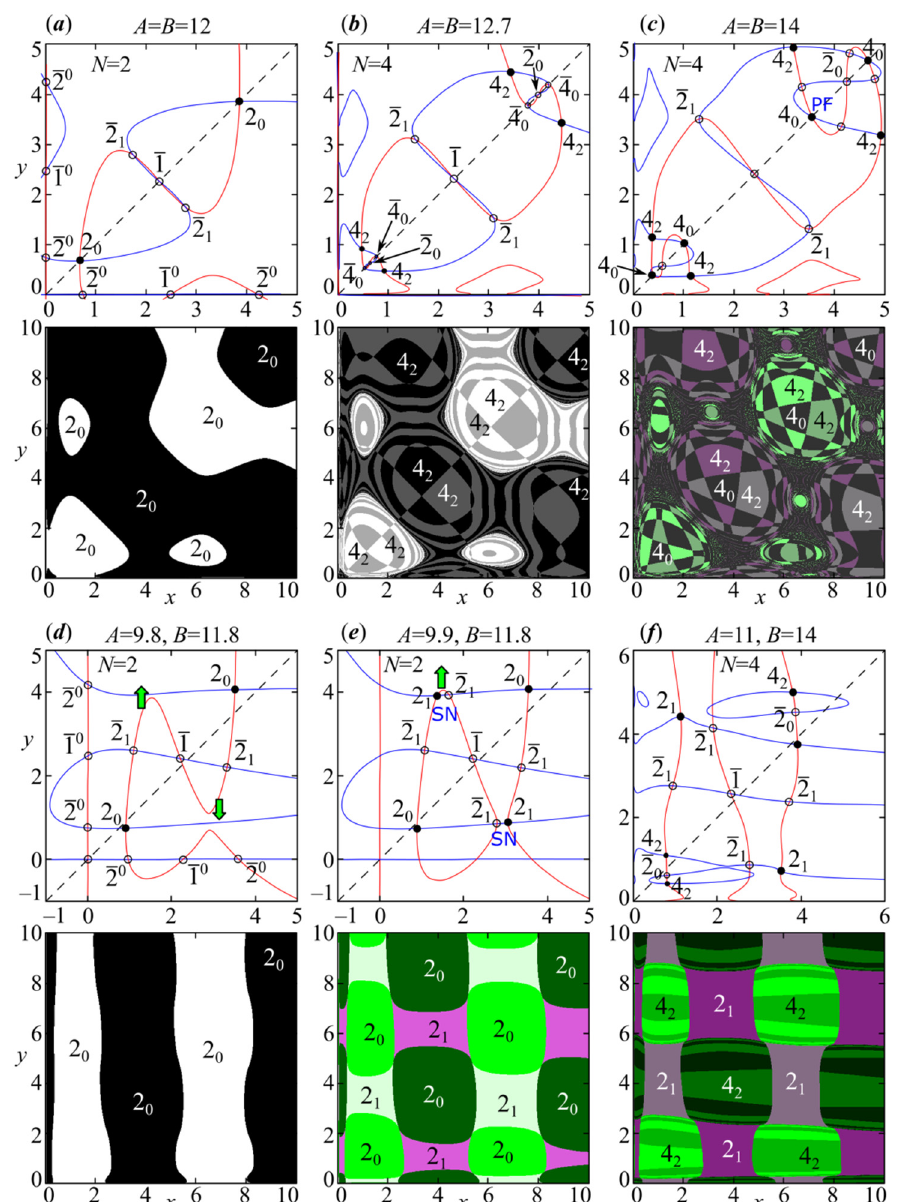
Figure 6. ( 1, 3 rows ) System (14) nullclines show the mechanism of periodic point emergence for system (4); ( 2, 4 rows ) Attraction basins of stable points are the black circles above. ( a – c ) Symmetric case with A = B and φ = 0.1; ( d – f ) Asymmetric case at A ≠ B and φ =0.03 demonstrates the emergence of an out-of-phase 2-cycle through a saddle-node bifurcation (SN). Stable/unstable fixed points are designated as T τ / T τ and are marked by black/white circles. T is period, subscript τ is the phase shift of variable x n relative to y n . Attraction basins of different colors, marked in the same way, correspond to oscillations with the different initial phases.